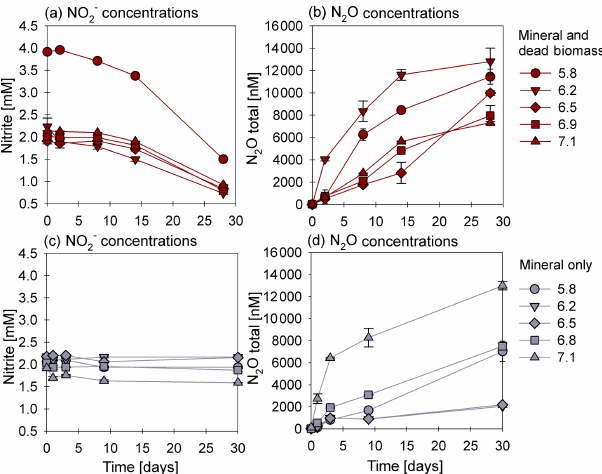
Figure 1. Nitrite reduction (a, c) and N 2 O production (b, d) over time in the mineral and dead biomass (red) and mineral-only (grey) set-ups over time and at different pH levels. Please note that twice the amount of nitrite was accidently introduced at a pH of 5.8. The standard error calculated from biological replicates ( n = 9) is rep- resented by the error